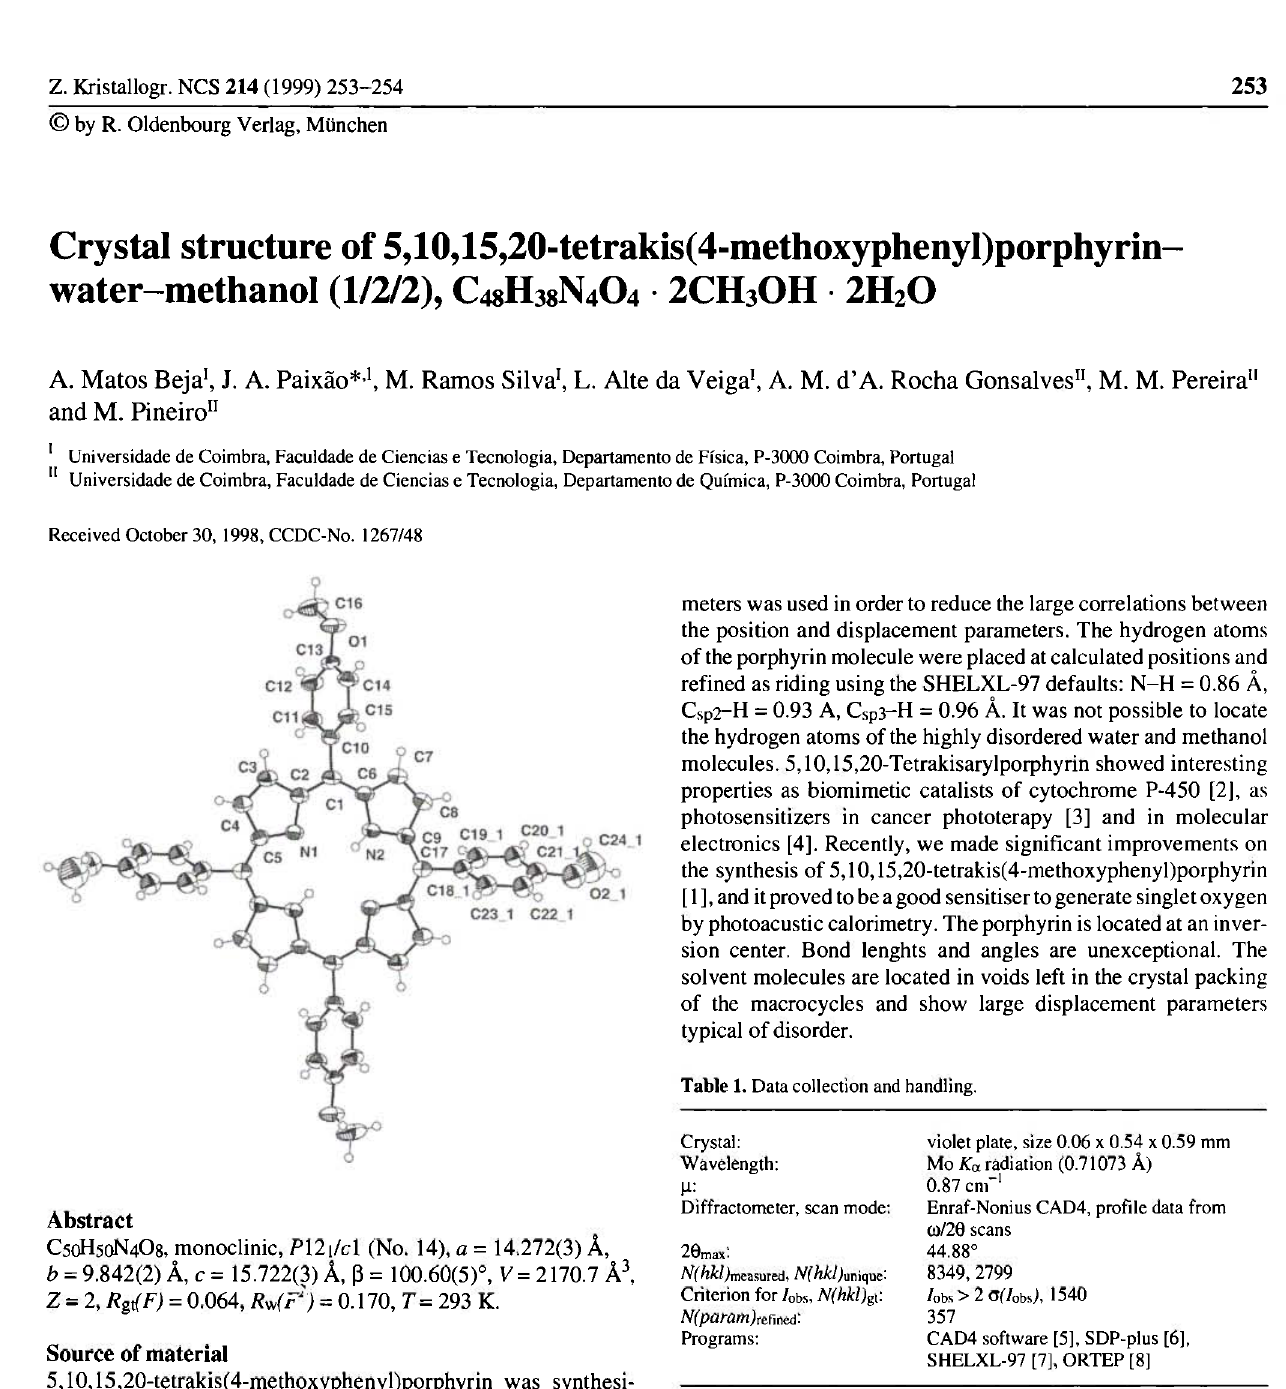
Table 2. Atomic coordinates and displacement parameters (in Ä 2